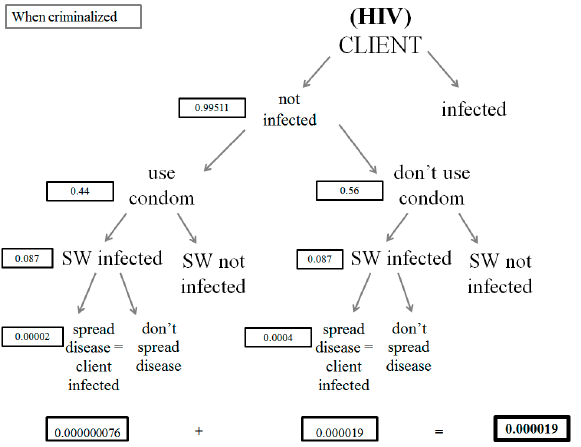
Figure A11. Risk of herpes transmission to a sex worker under decriminalization.